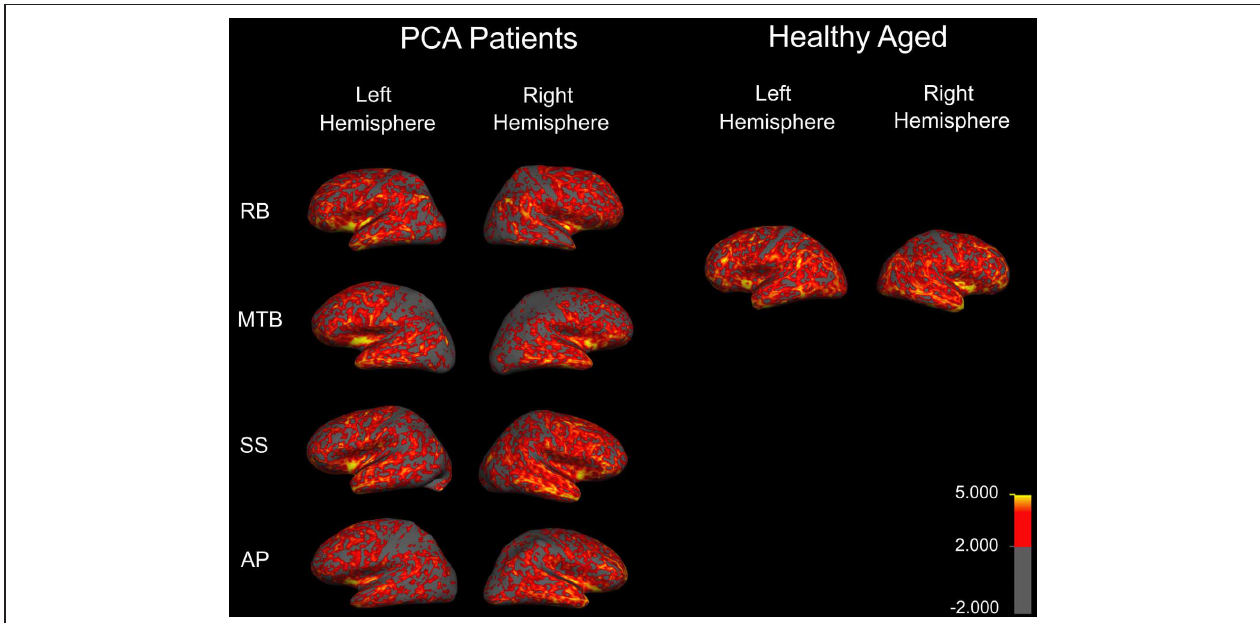
FIGURE 1 | Cortical thickness map obtained in the four patients with PCA. Maps are overlaid on inflated brains, so as to display thickness of cortex in sulci. A color spectrum was applied with yellow (5mm) and red (greater than 2mm) indicating areas of thicker cortex and gray indicating thin cortex (less than 2mm).